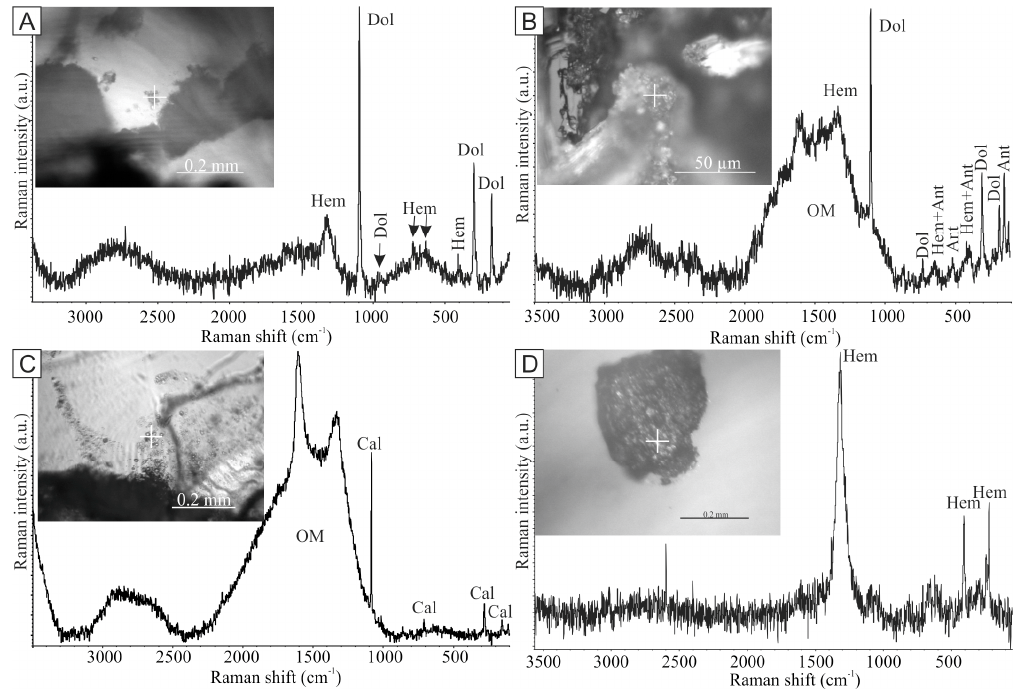
Figure 4. Microscopic images with location of the points of analysis and Raman spectra of: ( A ) dolomite (Dol) and hematite (Hem) inclusions in halite (depth − 1193.8 m a.s.l). ( B ) Dolomite (Dol) and hematite (Hem) inclusions in halite accompanied by small amounts of organic matter (OM) and finely dispersed anatase (Ant) crystals (depth − 1187.6 m a.s.l.). ( C ) Calcite (Cal) inclusions with larger amount of organic matter (OM) (depth − 1187.6 m a.s.l.). ( D ) Clean and large hematite (Hem) accumulation (depth − 1190.4 m a.s.l.).